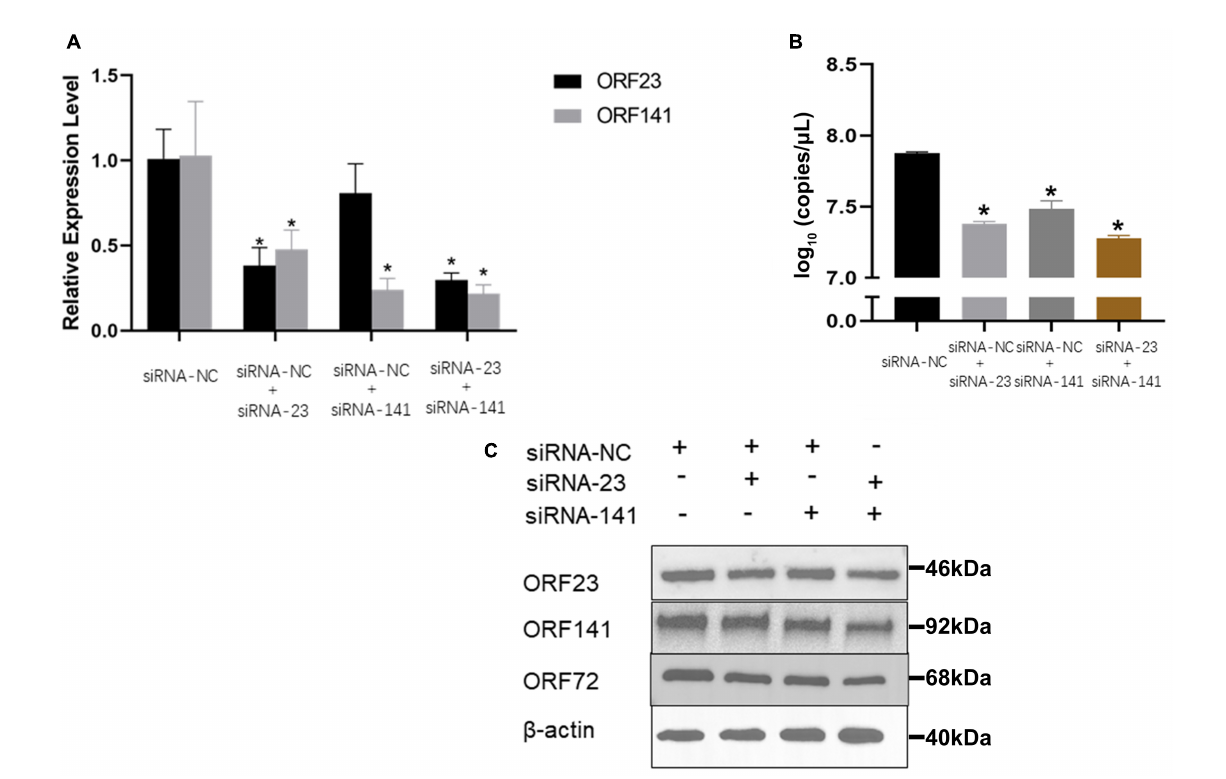
FIGURE7 The effect of different siRNA transfection on the relative expression of ORF23 and ORF141 and viral replication. (A) The transcription levels of ORF23 and ORF141 mRNA were detected 72 hpi after infection. The β -actin as a reference gene. (B) Effect of transfection of different siRNAs on copies number of CyHV-2 in cell supernatant 96 hpi. (C) Changes of ORF72, ORF23, and ORF141 protein levels in transfected cells at 96 hpi. Protein normalization results in Supplementary Figure 6 . The β - actin is used as a loading control. Mean ± SEM shows representative data sets from three independent experiments, * P < 0.05 vs. NC group.